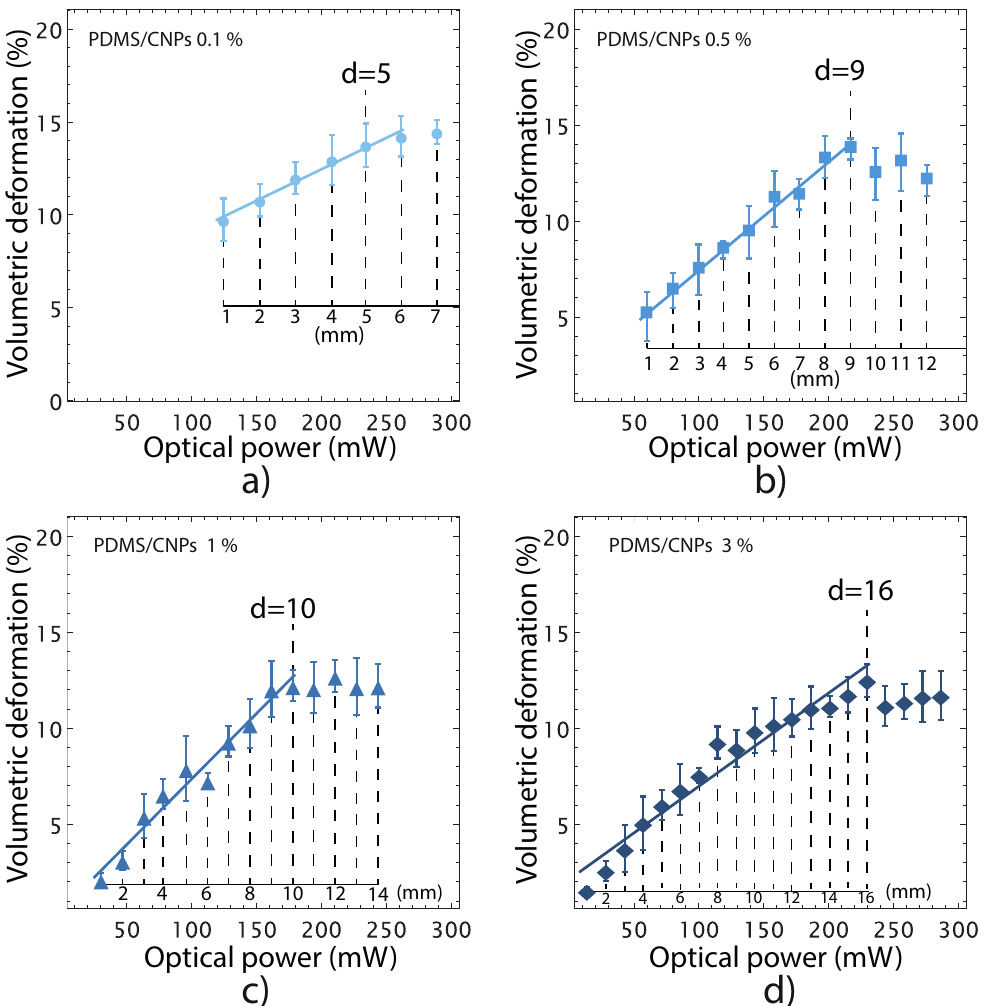
Figure 6. Volumetric deformation of the nanocomposites caused by NIR irradiation. The irradiation distances—used to obtain each point in the curves—are indicated in the inset axes: ( a ) PDMS/CNPs 0.1% showing a maximum deformation with an optimal distance equal to 5 mm; ( b ) PDMS/CNPs 0.5% showing a maximum deformation with an optimal distance equal to 9 mm; ( c ) PDMS/CNPs 1% showing a maximum deformation with an optimal distance equal to 10 mm; and ( d ) PDMS/CNPs 3% showing a maximum deformation with an optimal distance equal to 16